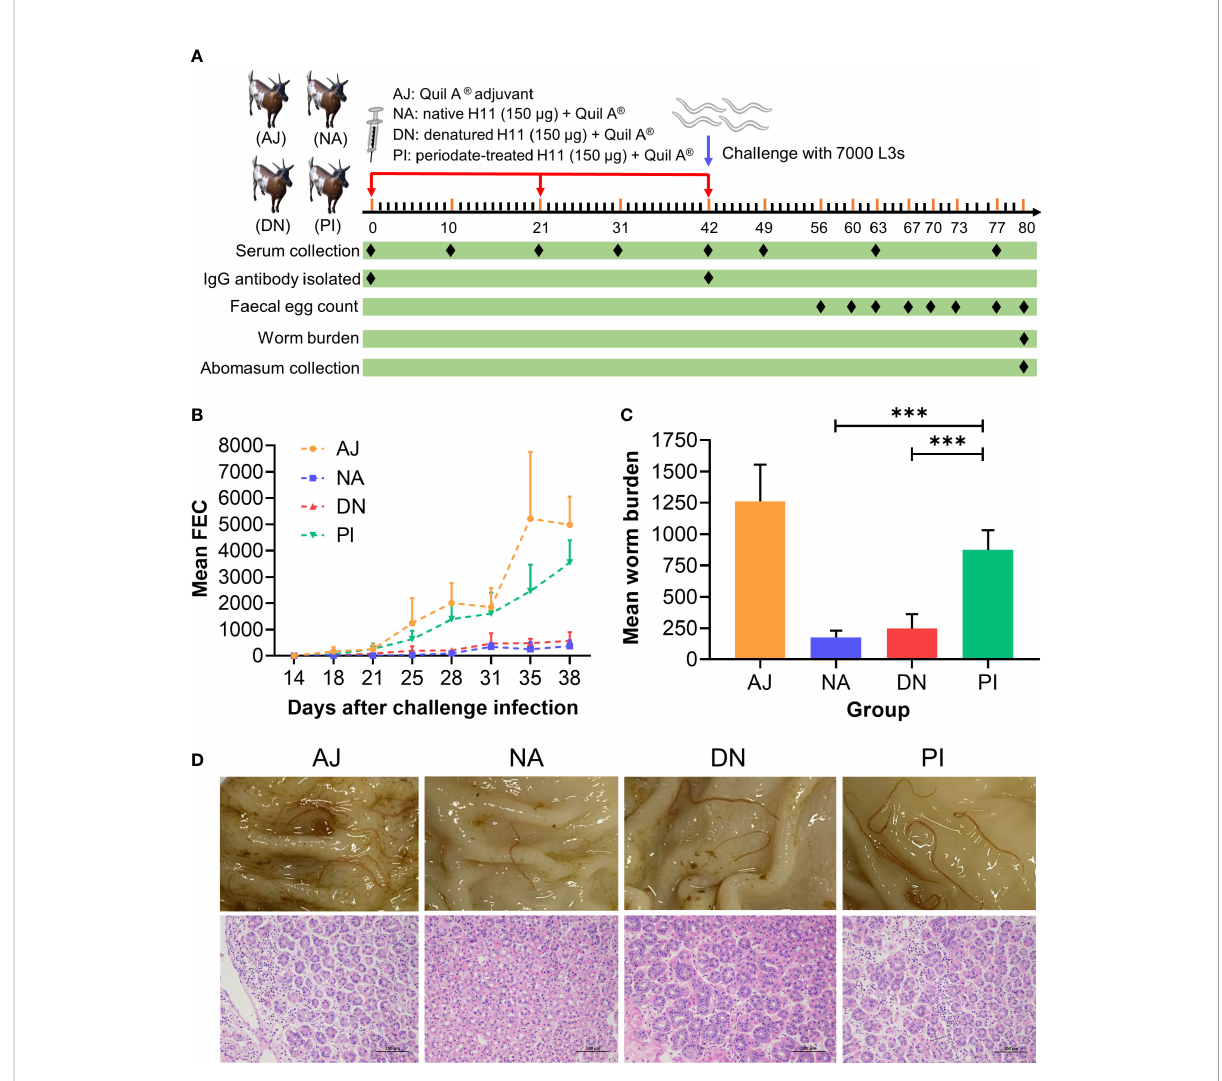
FIGURE 4 N-glycan moieties on H11 induce prominent protective immunity in goats against Haemonchus contortus infection. (A) Design of the animal trial. Four groups of fi ve goats each were injected with Quil A ® adjuvant alone (AJ), native H11 (NA), denatured H11 (DN) or periodate-treated H11 (PI), respectively, each with 150 m g proteins equivalent in Quil-A ® . Each goat was immunised subcutaneously three times at three-week intervals (days 0, 21 and 42; red arrow) and then challenged with 7000 infective third-stage larvae (L3s) on day 42 (blue arrow). One goat in group PI died of an unrelated cause. The time points for serum collection (eight times), IgG isolation (twice), faecal sample collection (eight times), worm sample collection (once) and abomasum collection (once) are indicated with black diamond. The numbers of eggs per gram faecal sample (faecal egg count, FEC) were counted under microscopy and normalised to the numbers of adult worms. (B) Mean group FEC (mean ± SD; AJ, n = 5; NA, n = 5; DN, n = 5 and PI, n = 4) was monitored at eight time points (days 14, 18, 21, 25, 28, 31, 35 and 38 after challenge infection). (C) Mean group worm burden (mean ± SD; AJ, n = 5; NA, n = 5; DN, n = 5 and PI, n = 4) was counted at the end of the experiment (day 80). Statistical signi fi cance was determined using one-way ANOVA, *** p < 0.001. (D) Representative images showing the H. contortus adults (upper panel) and hematoxylin and eosin(HE) staining (lower panel) in individual abomasa of goats from four groups (AJ, NA, DN and PI). Evident pathological alterations in the abomasum show atrophy and cell necrosis of glands, enhanced eosinophilia and lymphocyte in fi ltration. Scale bars: 100